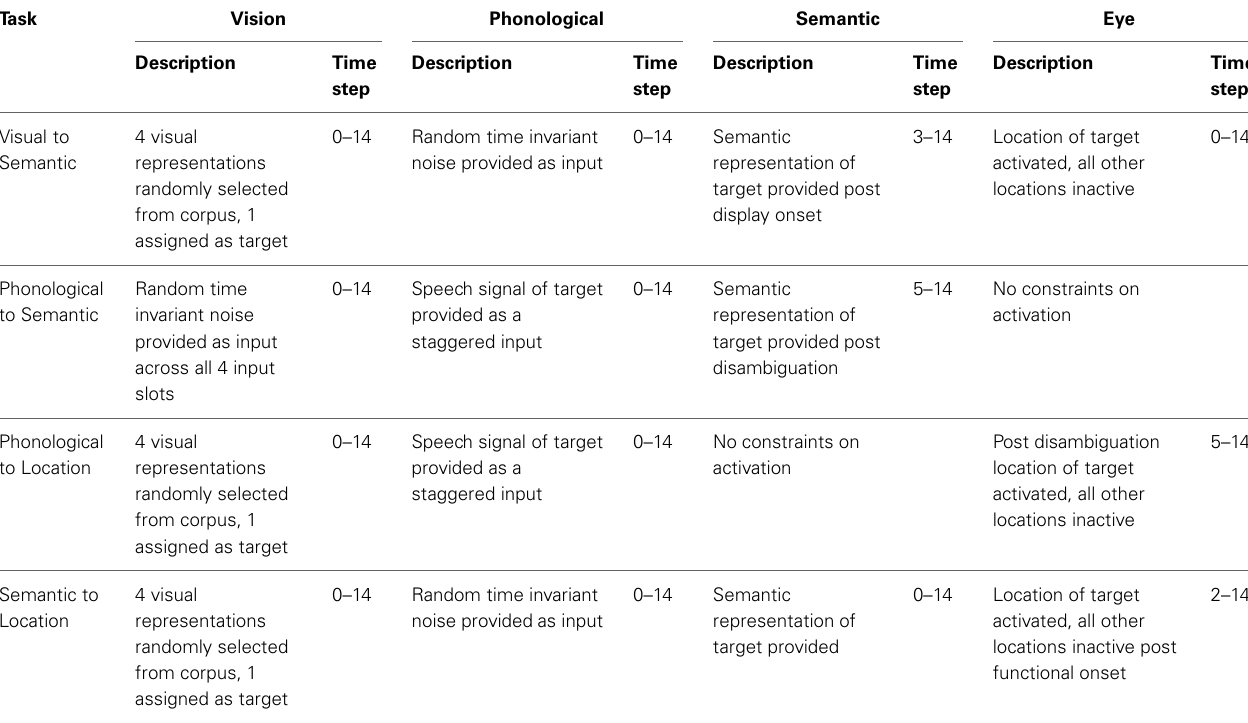
Table 2 | Temporal organization of events in model